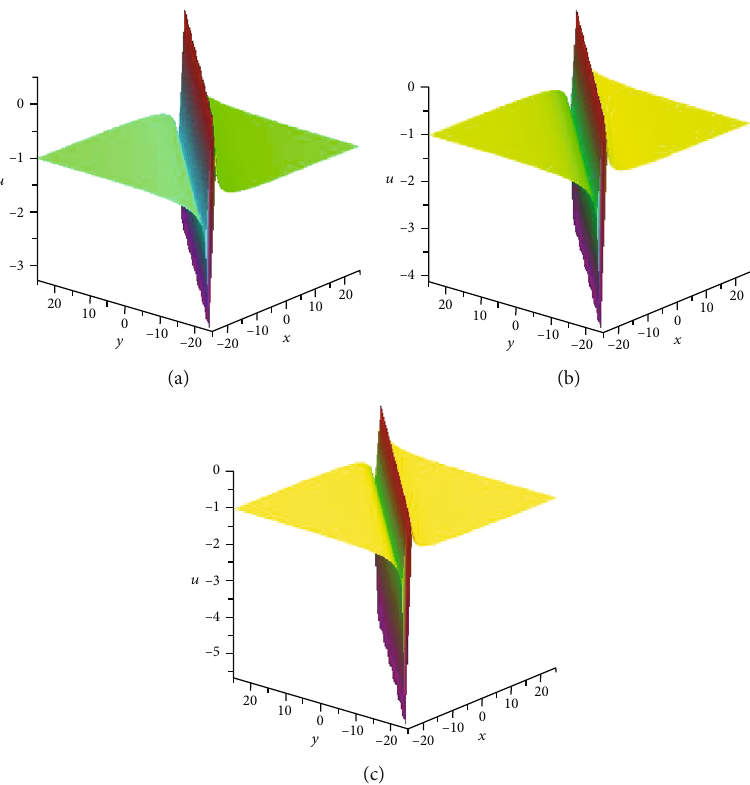
Figure 5: Evolution of Equation (65) at (a) t = 0 : 4 , (b) t = 0 : 45 , and (c) t = 0 : 5